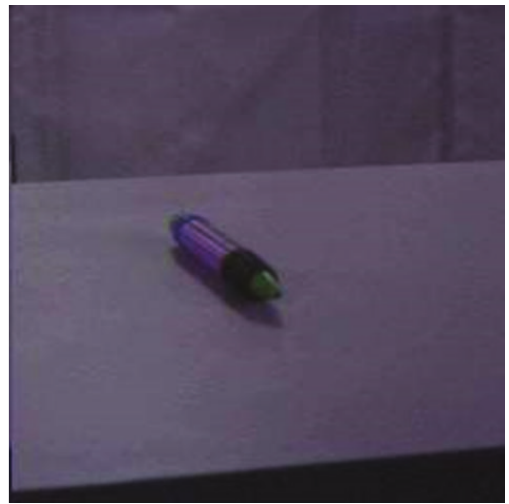
Figure 9: Pen at 𝜃 = 10 ∘ and 𝜙 = 18 ∘ .